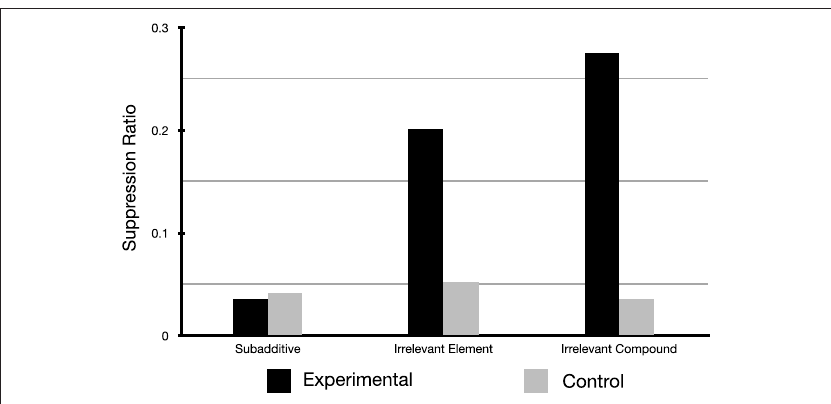
FiGurE 1 | results of Experiment 1 redrawn from Beckers et al.